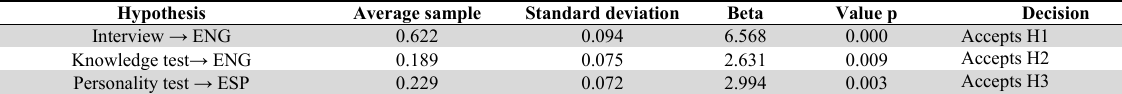
Results of the model structure